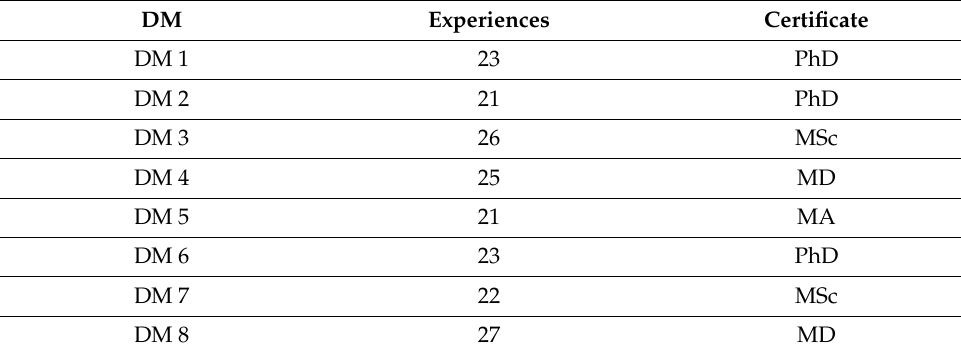
Table 2. Information of DMs.